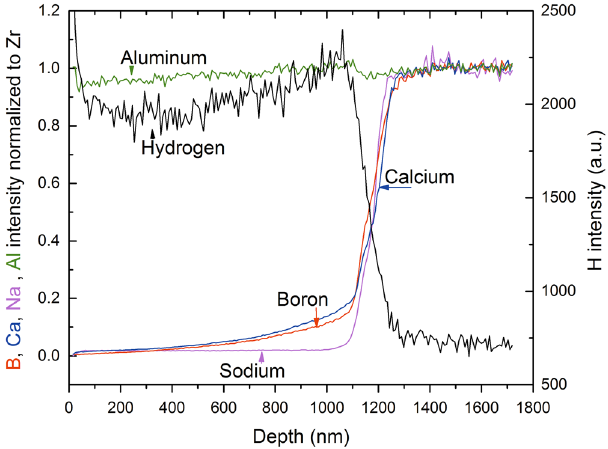
Fig. 4 TOF-SIMS derived elemental pro fi les of the major glass constitutes of a monolith withdrawn at day 70, immediately before the addition of magnetite. This allows for a direct comparison of the monoliths with the reference experiment before the system was disturbed. 30 All elements, except H, are normalized to Zr, as this element is immobile during alteration and to their concentration in the pristine glass, which allows for a qualitative comparison between the